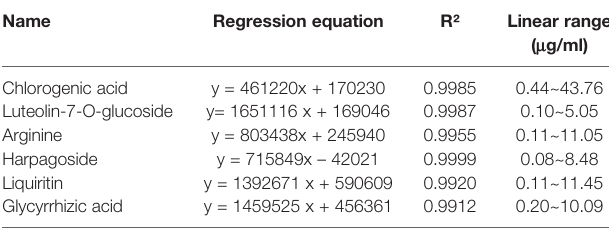
TABLE 2 | Regression equation of UHPLC-TOF-MS method for the quanti fi cation analysis.